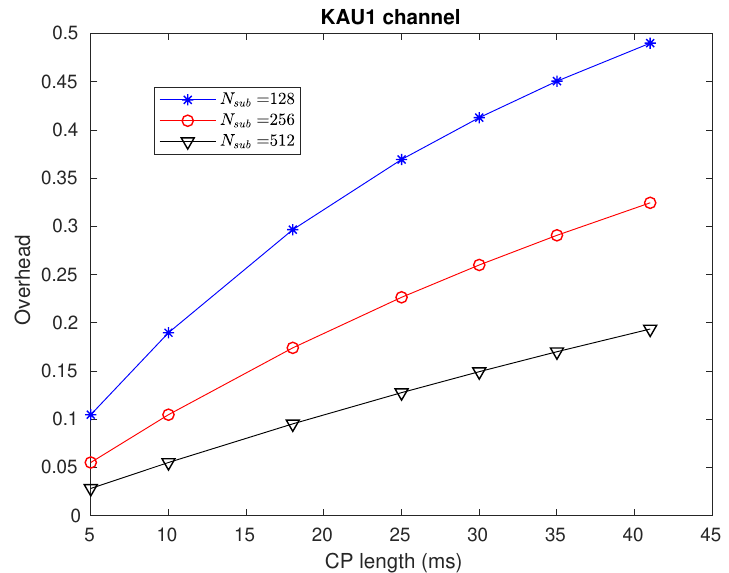
Figure 14. Corresponding overhead for each parameters pair for KAU1